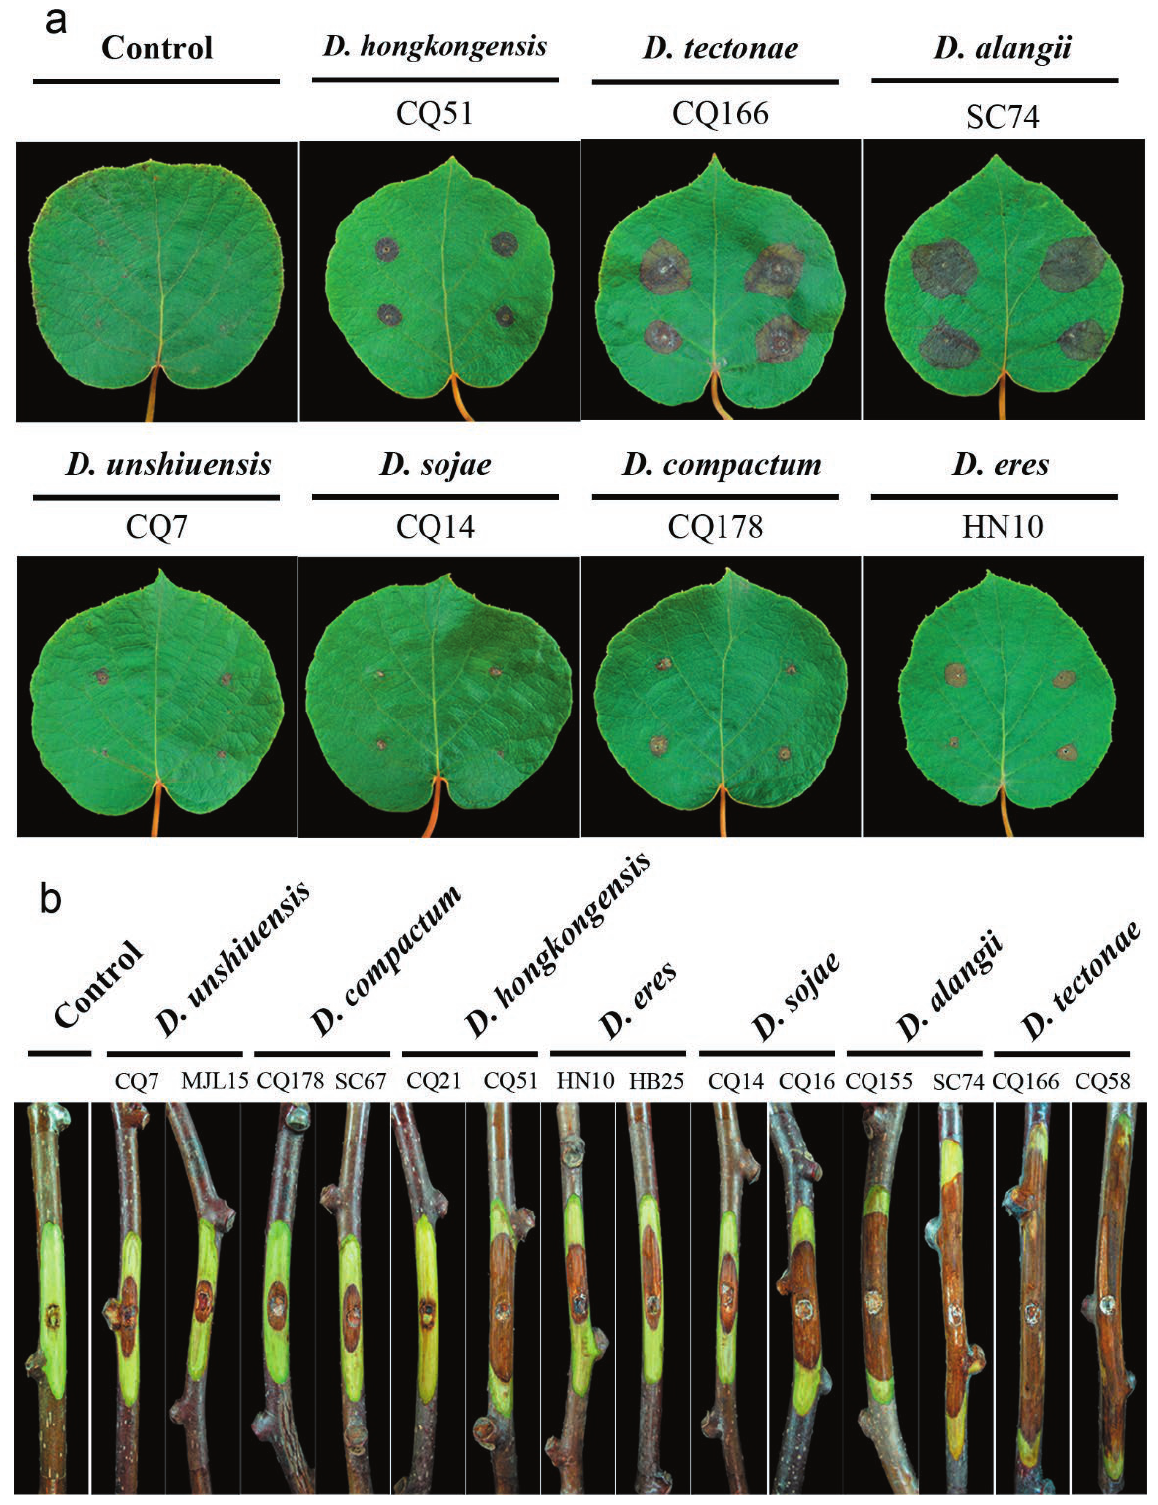
Figure 5. Pathogenesis of seven Diaporthe species on kiwifruit leaves and stems. a, symptoms caused after inoculation of wounded kiwi leaves ( Actinidia chinensis ‘Cuiyu’) with mycelium plugs from cultures of seven Diaporthe spp. b, symptoms caused by inoculation of wounded kiwi branches ( Actinidia chinensis ‘Hongyang’) with mycelium plugs from cultures of seven Diaporthe